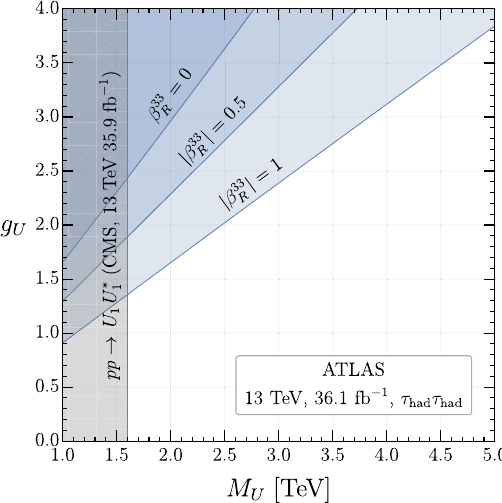
Fig. 1 Exclusion plot for the pp → ττ search in the ( g U , M U ) (left) , M ) (right) planes for different values of the coupling β 33 and (β 23 U L = 1 and the leptoquark width to its natural value. In the left We fix β 33 L